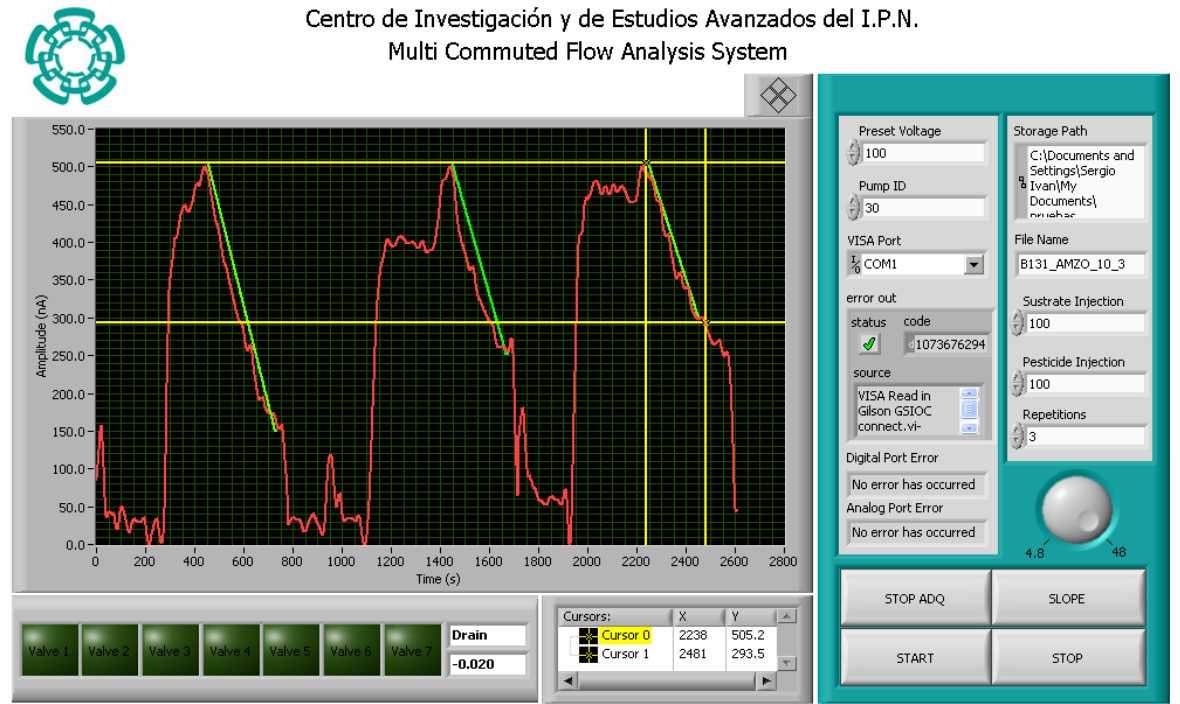
Figure 4. Protocol of enzyme inhibition in the steady-state to measure the inhibition response.